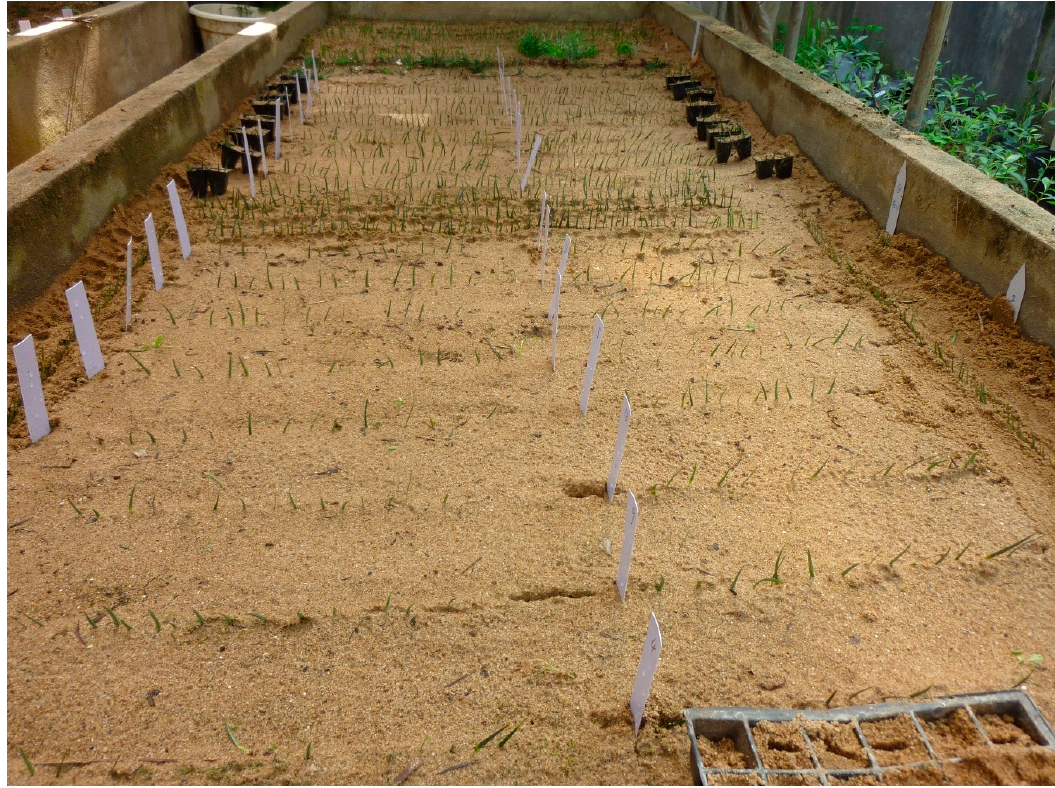
Figure 1. Leaf cutting propagation of Chinese fir in the greenhouse.